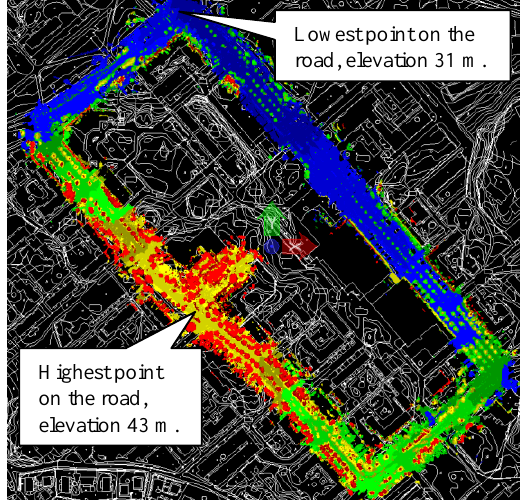
Figure 2. Digital surface model of Espoonlahti test field (based on MLS data). (Background map data © City of Espoo.)